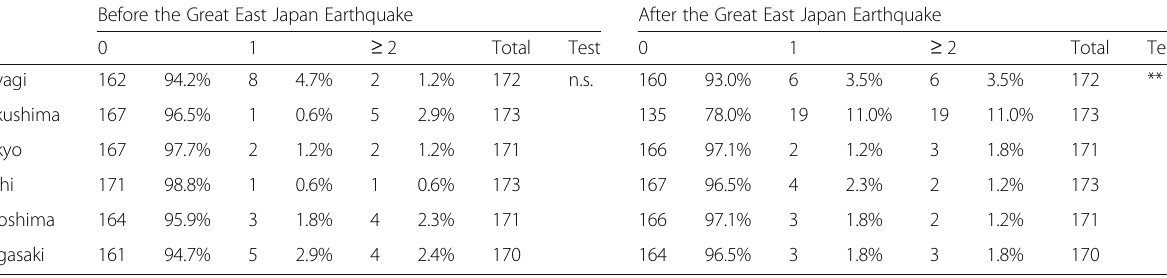
Table 2 Number of participations to the forum/meeting of the risk communication relating to the effect of radiation to the human body Before the Great East Japan Earthquake